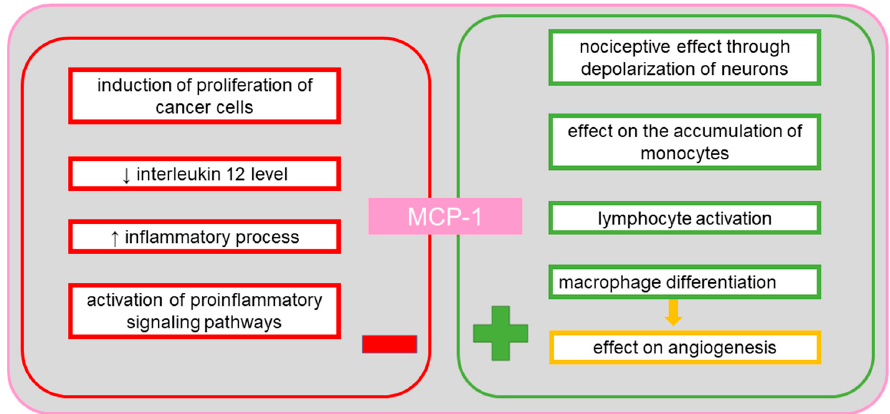
Figure 5. The positive and the negative systemic effects of monocyte chemotactic protein-1 (MCP-